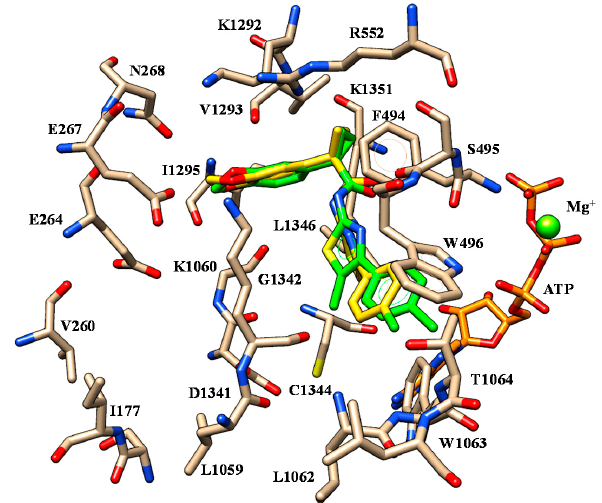
Figure 10. Selected docking mode of 6 (C atom; green) and 11 (C atom; yellow) within the modelled F508del-CFTR. The most important residues are labelled.